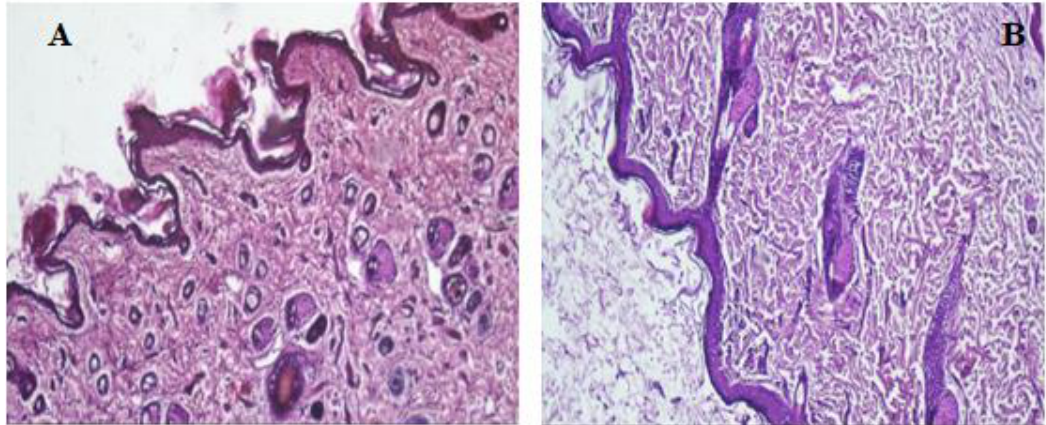
Figure 6. Histopathological evaluation of sections of rat abdominal tissues. a. Rat abdominal tissue incubated in the diffusion chamber with LXM loaded microneedle patch showing the created channels, b. Rat abdominal tissue incubated in phosphate buffer pH